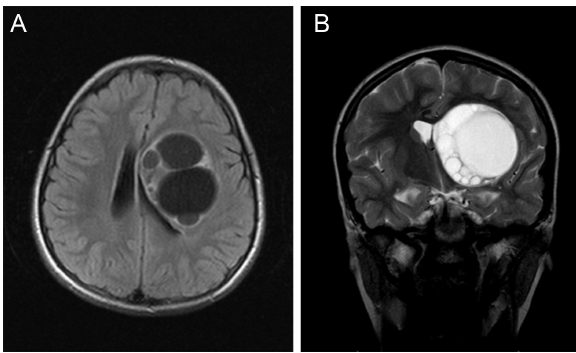
Figure 10. A,B. Axial FLAIR (A) and coronal T2-weighted (B) magnetic resonance image of the brain demonstrating a well-defined T2 hyperintense lesion that is totally suppressed on the FLAIR sequence, with no sign of perilesional edema.